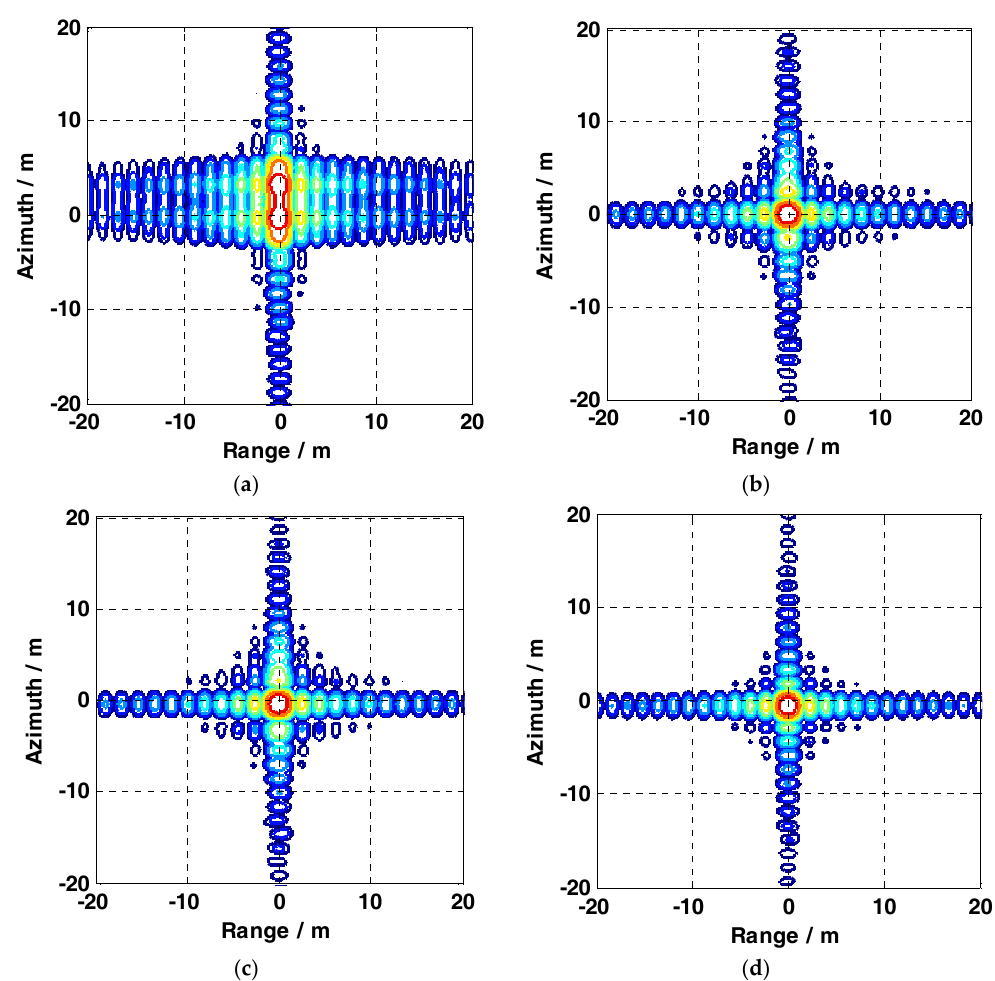
Figure 11. Target 5’s contours processed by ( a ) the conventional SAR imaging algorithm (CS algorithm), ( b ) MD algorithm, ( c ) PGA algorithm, and ( d ) BLUE algorithm, for sliding spotlight SAR data with mild accelerated motion error.